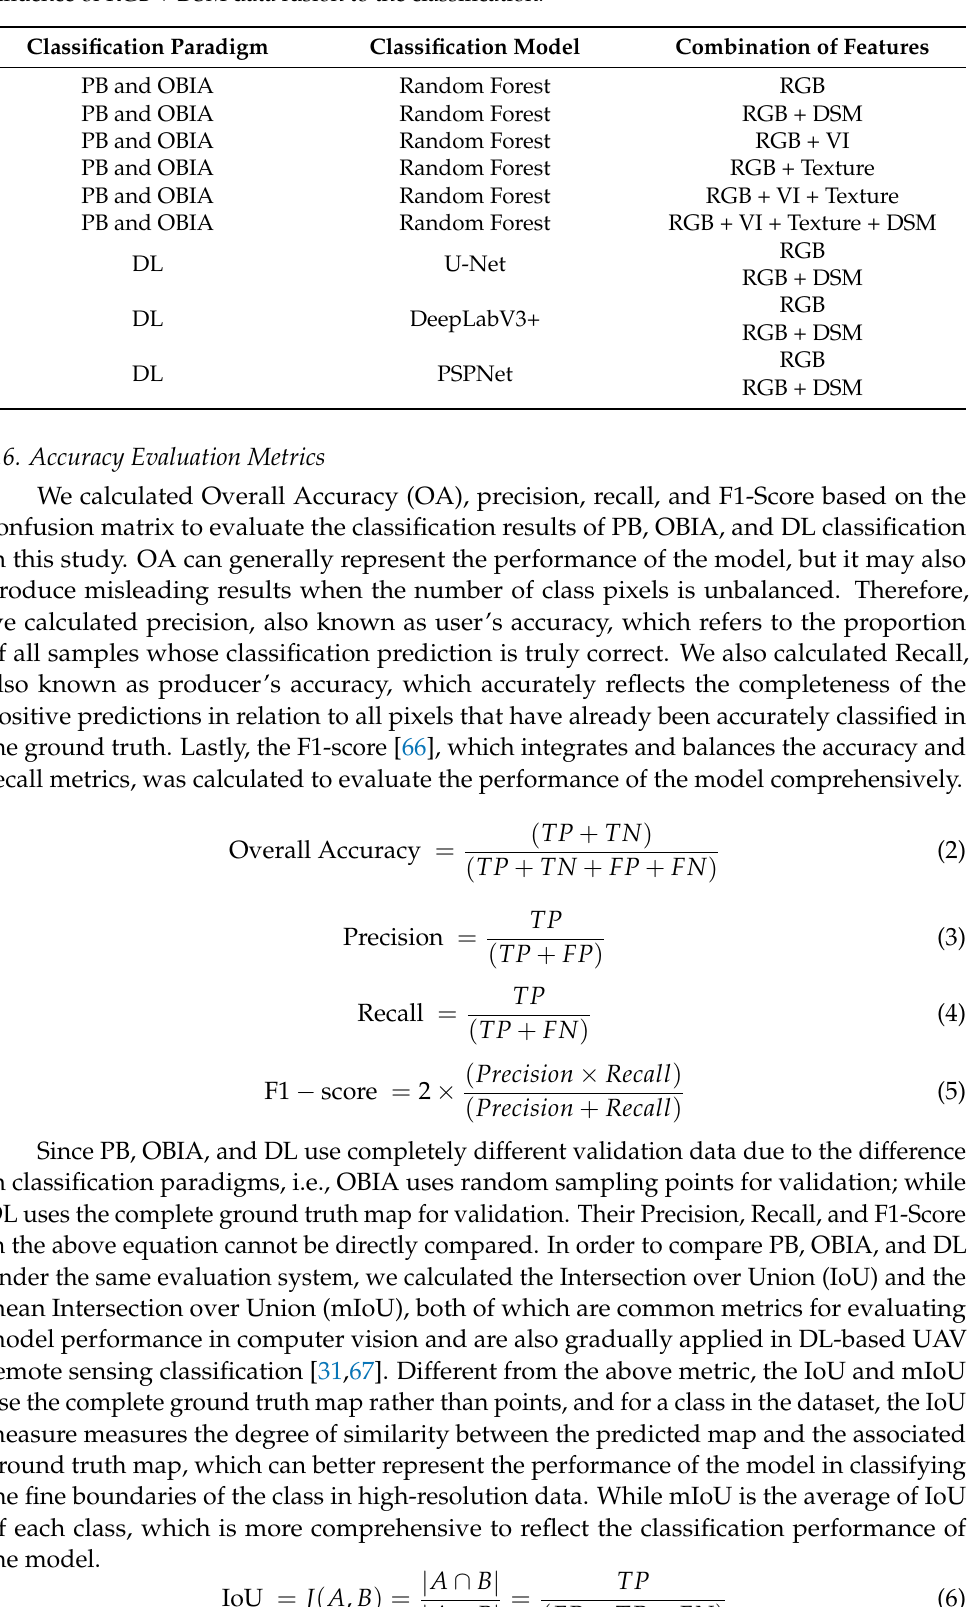
Table 4. The experimental design in this study. In the PB and OBIA methods, we tested the classifi- cation performance of different combinations of bands; while in the DL method, we evaluated the influence of RGB + DSM data fusion to the